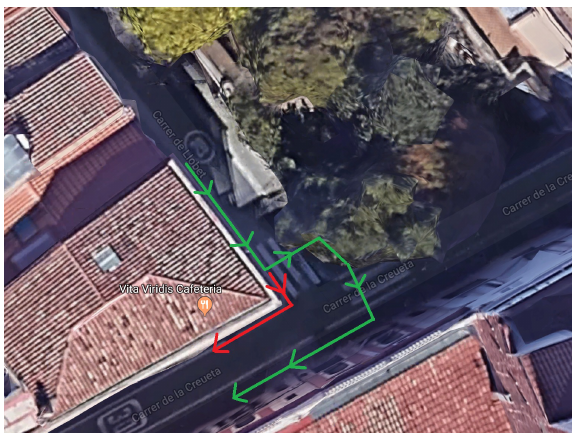
Figure 8. Scheme with recommendations for use at a corner where cars may mount the sidewalk.